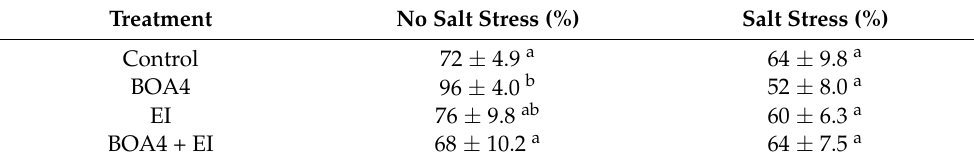
Table 1. Final germination percentage of tomato seeds in the absence and presence of salt stress †. Treatment